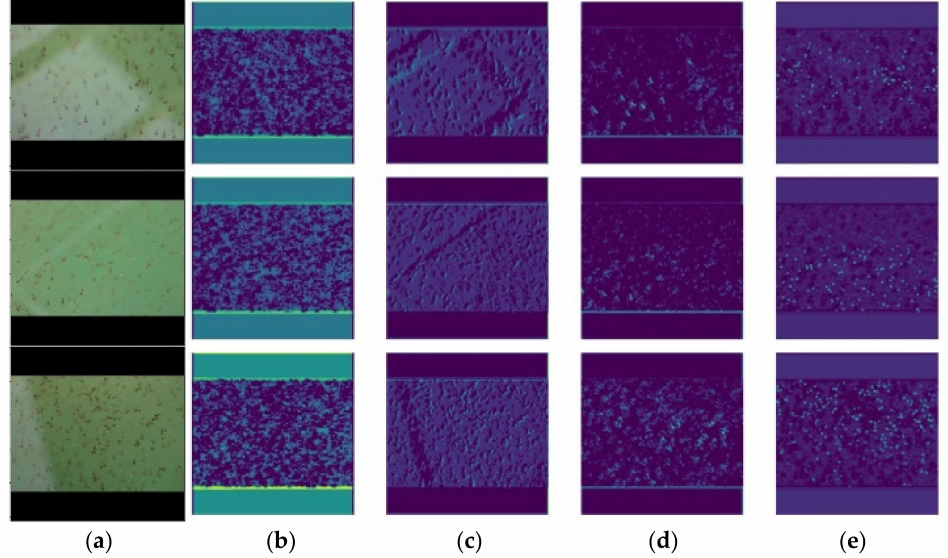
Figure 16. ( a ) Image of shrimp by density: row 1, less dense with the actual number of shrimps of 46 and predicted number of shrimps of 46; row 2, medium dense with the actual number of 118 and predicted number of 118; row 3, dense with the actual number of 188 and predicted a number of 170. ( b ) Layer of Resnet101 res2c_out, ( c ) layer of Resnet101 res3c_out, ( d ) layer of Resnet101 res4w_out and ( e ) predicted number of shrimps.